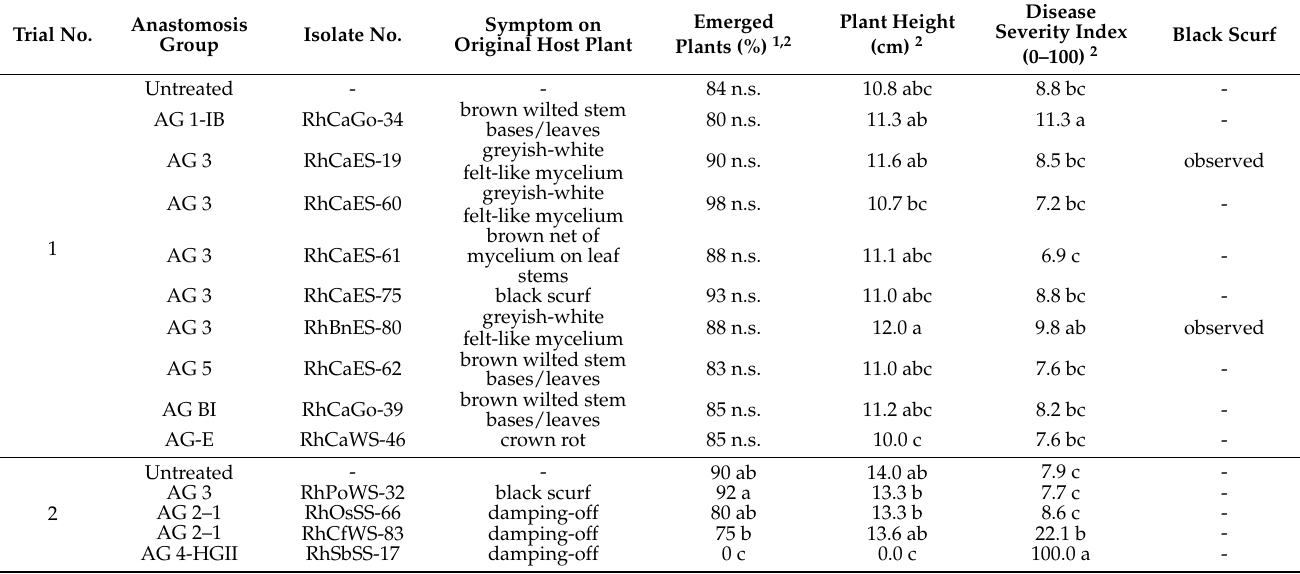
Table 3. Pathogenicity of ten Rhizoctonia isolates towards young carrot plants (cv. Romance F1), performed in two greenhouse trials. In the second trial, RhOsSS-66 and RhCfWS-83 (both AG 2–1) and RhSbSS-17 (AG 4-HGII) were used as positive control treatments.